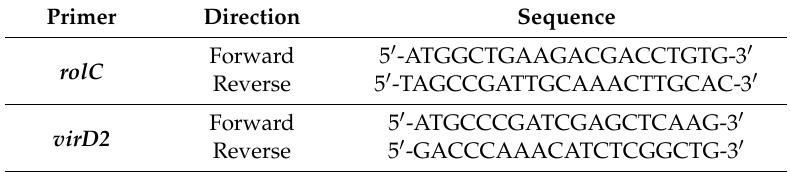
Table 1. Sequences of primers used for confirmation of the genetic transformation [61,63].